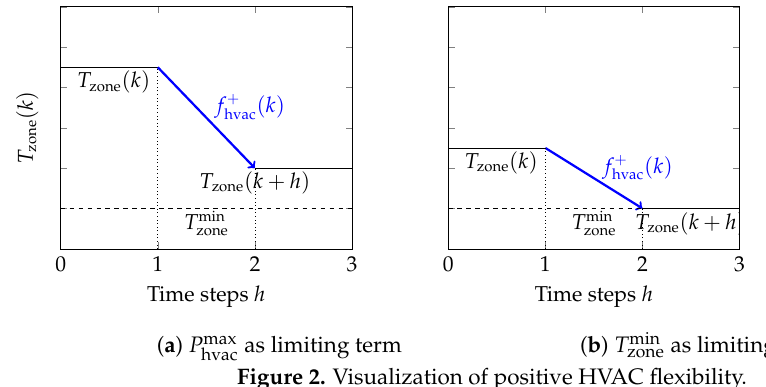
Figure 2. Visualization of positive HVAC